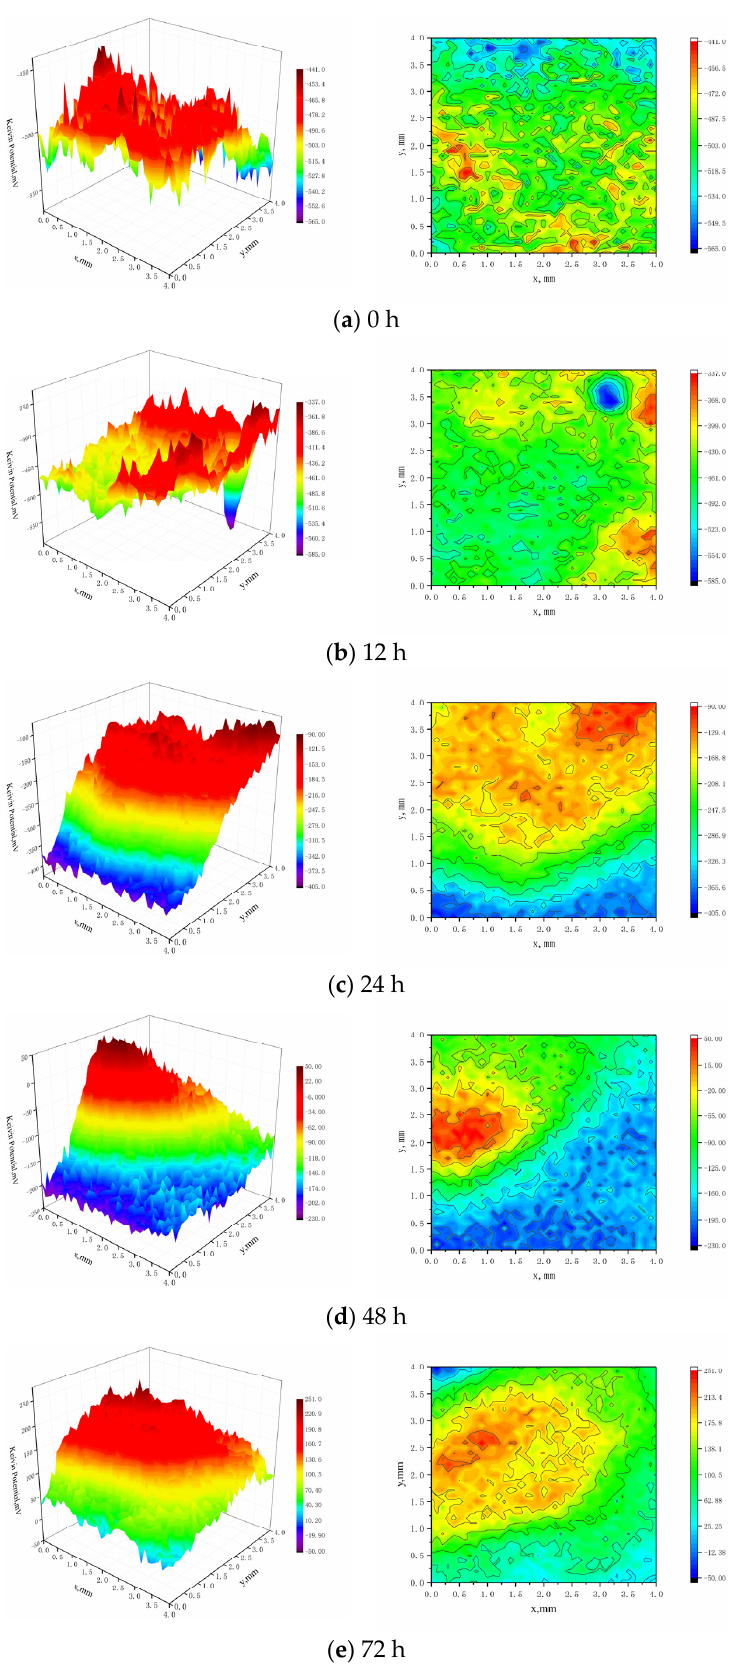
Figure 11. SKP Potential Distribution on the Surface of